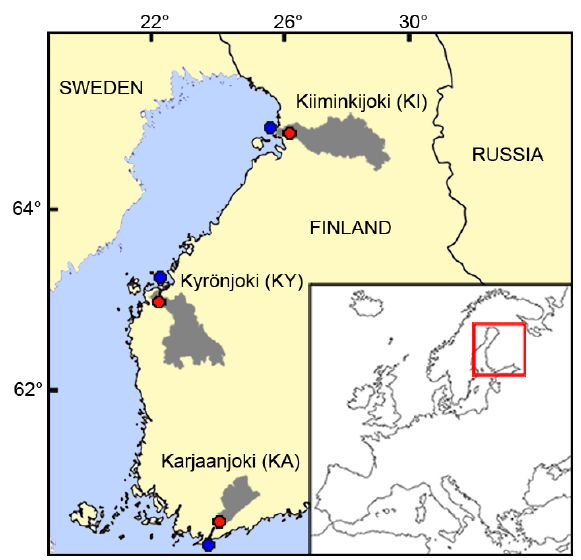
Fig. 1. Map showing the catchment areas (shaded grey) and the sam- pling locations of study estuaries. Red circles mark the sampling point of each river endmember, and blue circles the respective sea endmembers in the Baltic Sea